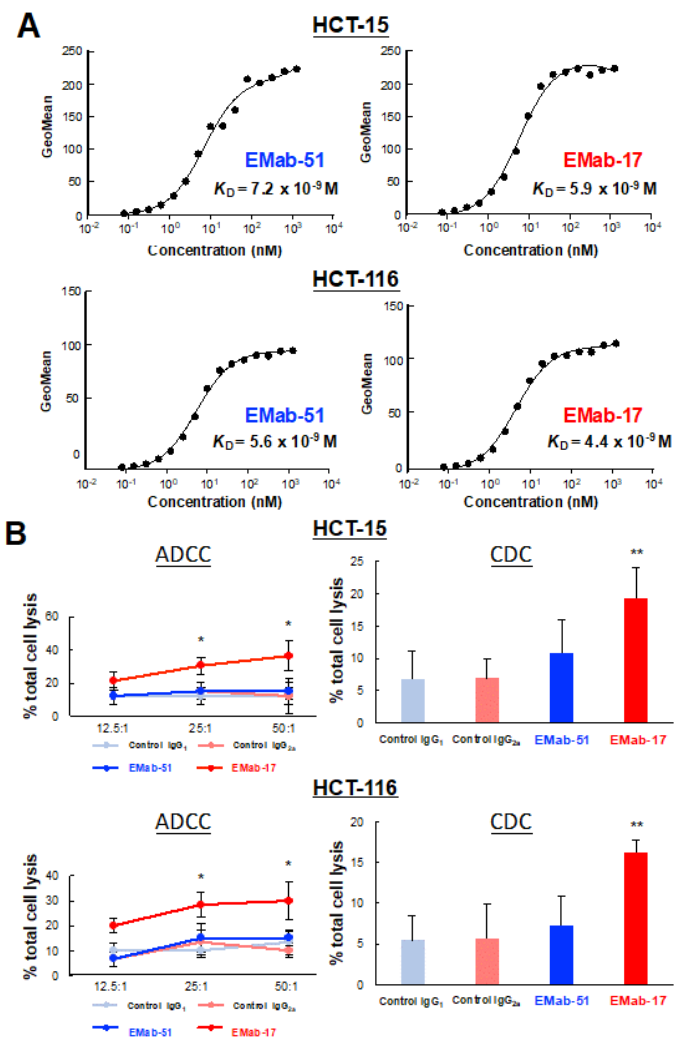
Figure 4. Determination of the binding affinity and ADCC and CDC activities of EMab-17 or EMab-51 using flow cytometry. ( A ) HCT-15 ( Top ) and HCT-116 ( Bottom ) cells were suspended in 100 μ L of serially diluted EMab-17 or EMab-51 (6 to 100 ng/mL), followed by the addition of secondary anti-mouse IgG. Fluorescence data were collected using a cell analyzer. ( B ) The ADCC and CDC activities of EMab-17 or EMab-51 against HCT-15 ( Top ) or HCT-116 ( Bottom ) cells were evaluated. ADCC activity was evaluated through the calcein-AM release assay in the presence of antibodies (100 μ g/mL; effector/target ratio, 12.5, 25 and 50). CDC activity was determined using the MTS assay in the presence of antibodies (100 μ g/mL) or control mouse IgGs (IgG 1 or IgG 2a , 100 μ g/mL) with 10% rabbit complement. The values are means (SD). *: p < 0.05, **: p < 0.01 vs. IgG 2a -treated control.